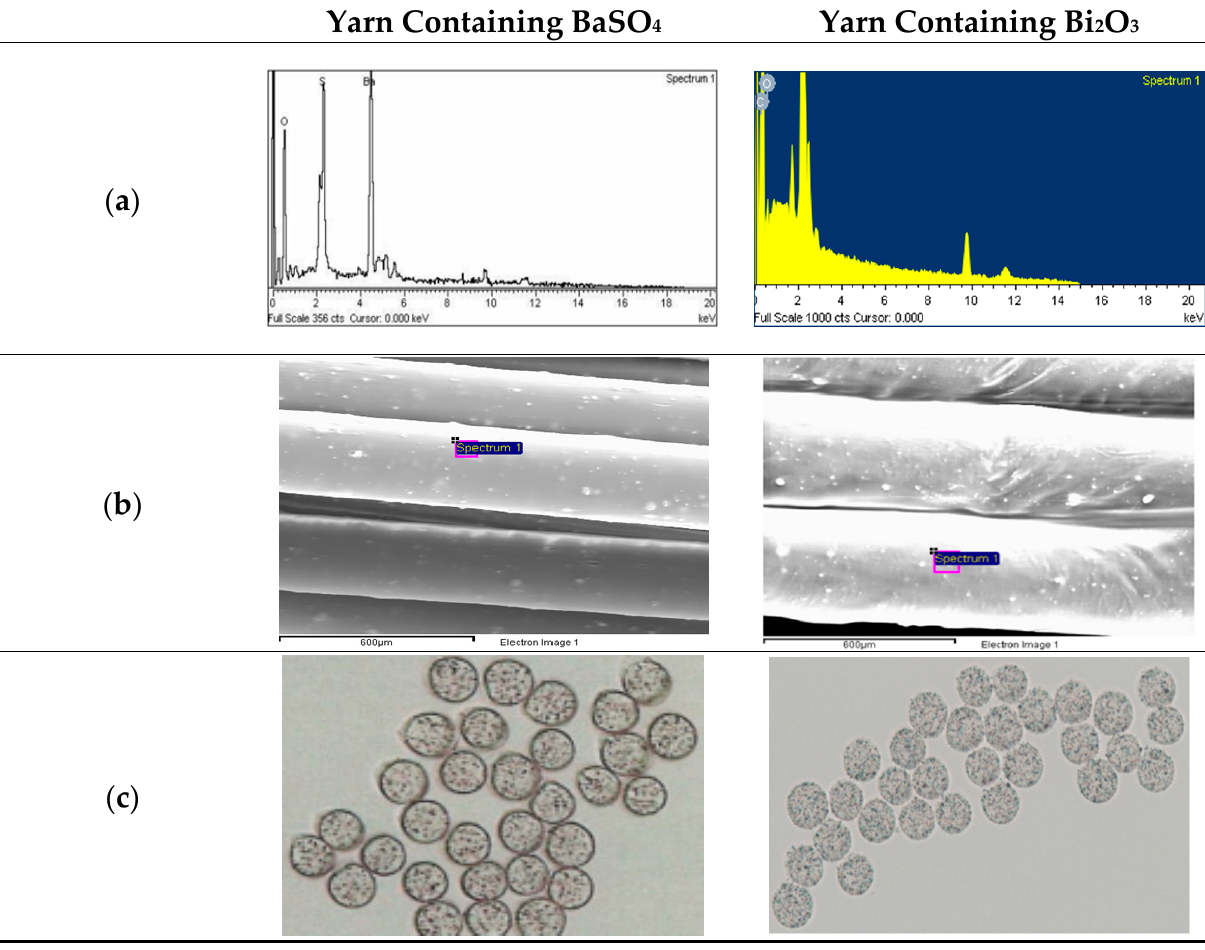
Figure 6. Conditions for weaving of the fabrics. Table 3. Characteristics of the shielding fiber fabrics.